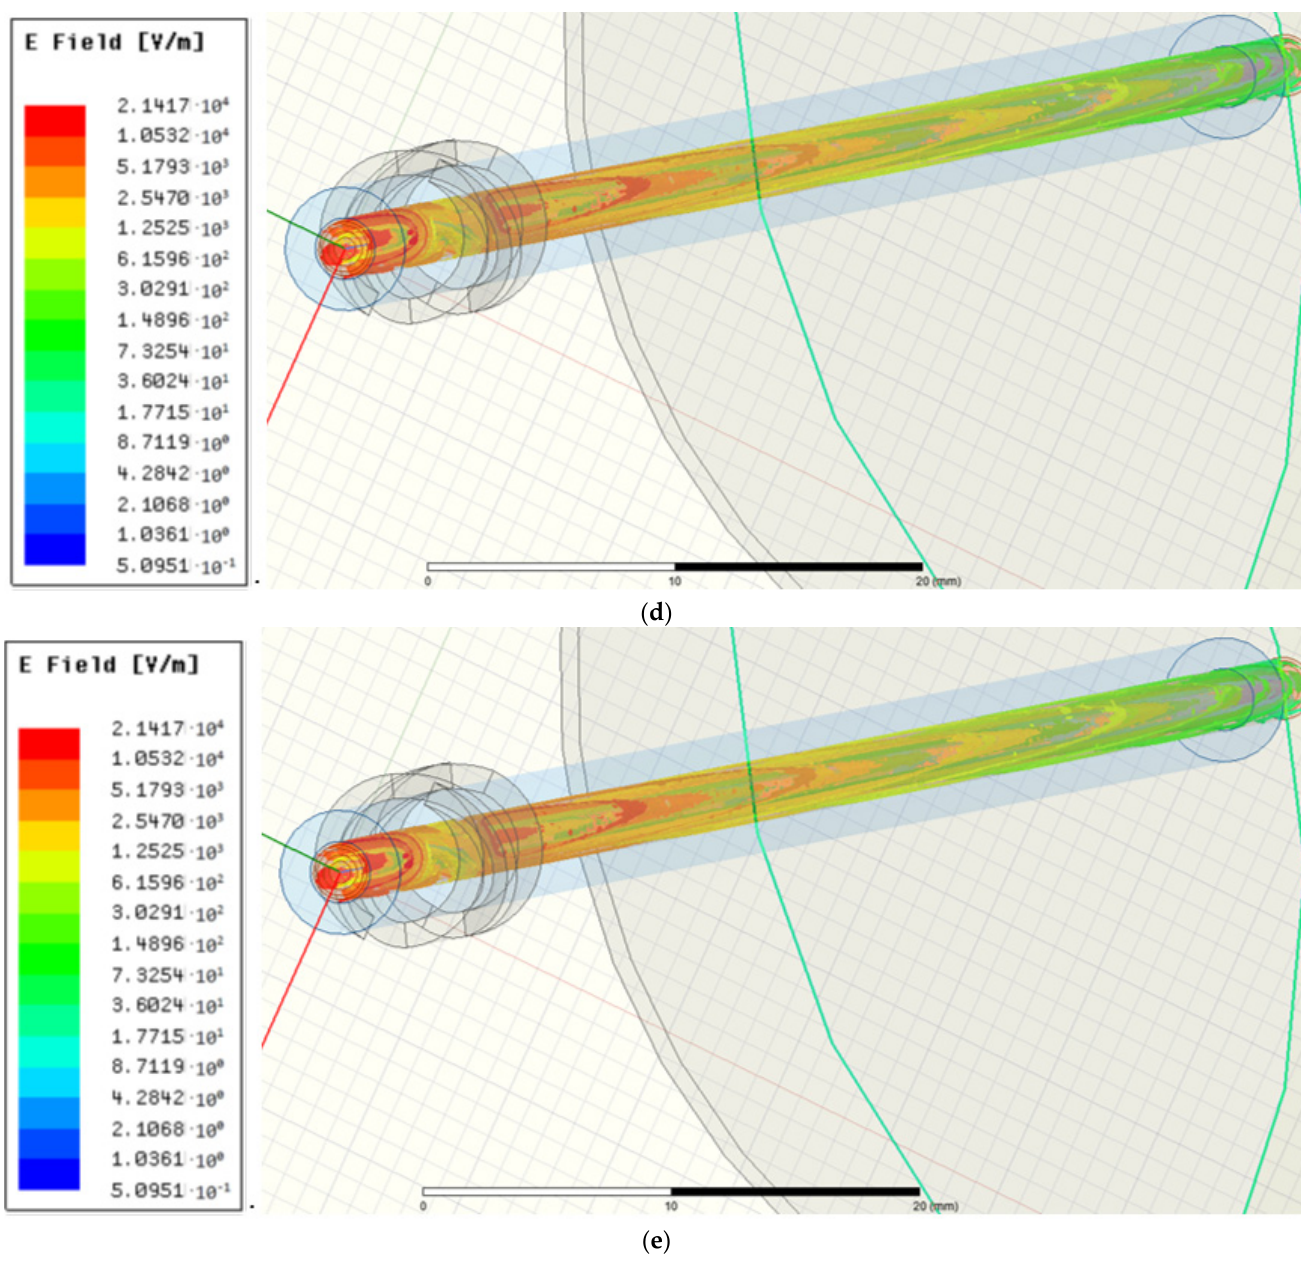
Figure 4. Analyzing and evaluating the geometrical arrangement of the plasma channel, single-turn electrode, external medium, and bottom metal plate: ( a ) the distribution of the volume loss density P vol [Wm − 3 ], f = 13.56 MHz, at the orifice; ( b ) the distribution of the intensity of the electric field E [Vm − 1 ], f = 13.56 MHz, at the orifice; ( c ) the overall distribution of the intensity of the magnetic field H [Am − 1 ], f = 13.56 MHz; ( d ) the overall distribution of the volume loss density P vol [Wm − 3 ], f = 13.56 MHz; ( e ) the overall distribution of the intensity of the electric field E [Vm − 1 ], f = 13.56 MHz.